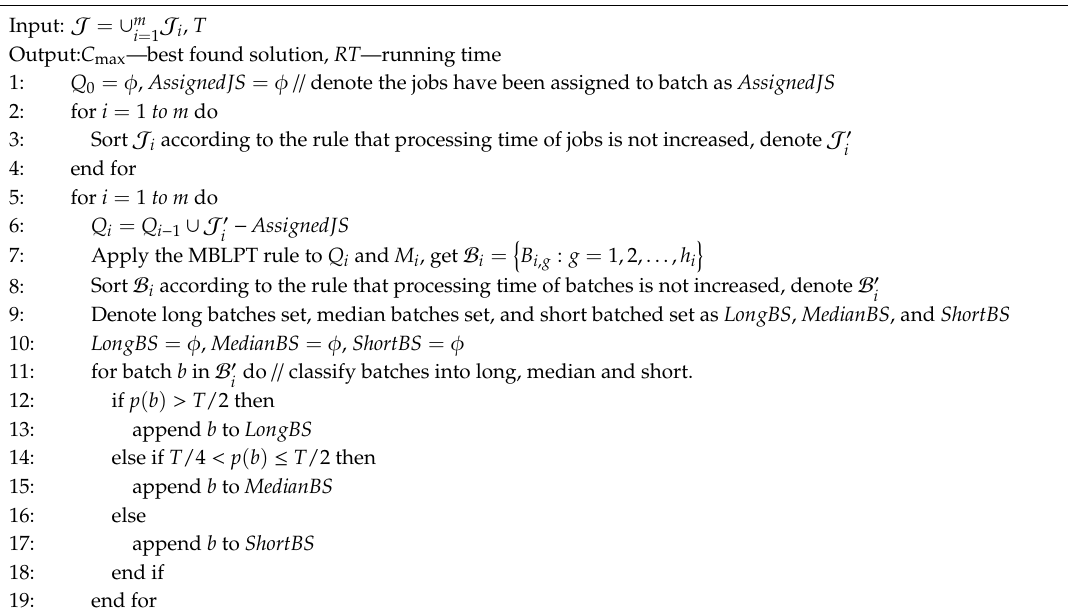
Algorithm 1. SCMF-LPTJF (smallest capacity machine first processed and longest processing time job first